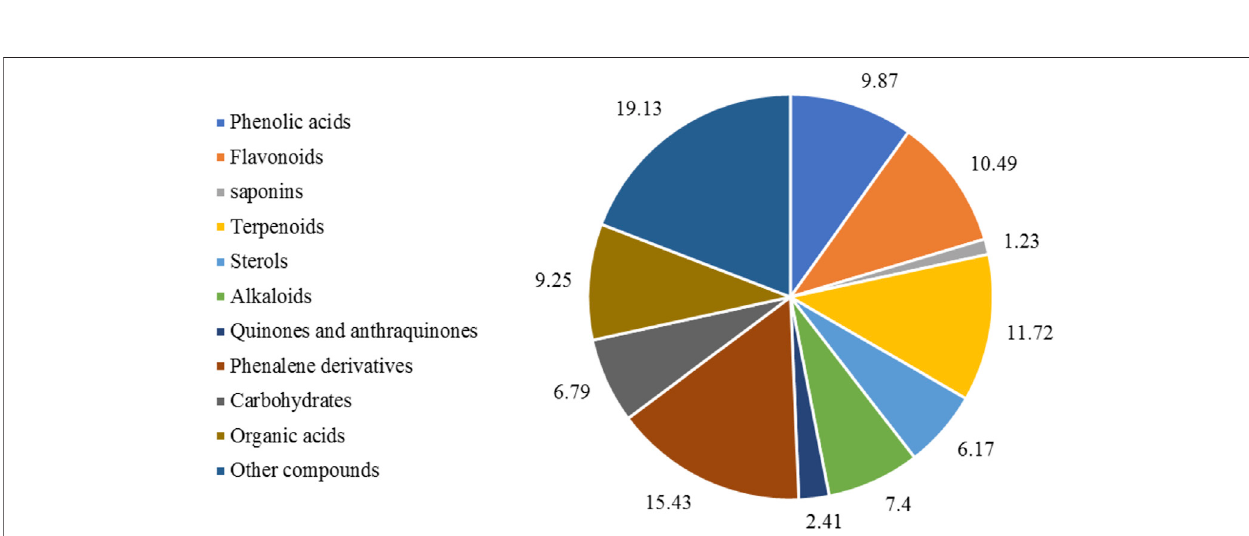
FIGURE3| Majorclassesandsubclassesofcompoundsisolatedfrom E.crassipes basedonthetotalnumberofphytochemicals.ThekeywordsusedontheWeb of Science were “ E . crassipes , ” OR “ water hyacinth ” “ phytocompounds, ” “ secondary metabolites, ” “ phenolic, ” “ fl avonoids, ” “ saponins, ” “ sterols, ” “ terpenoids, ” “ carbohydrates, ” “ quinones, ” “ tannins, ” “ organic acids, ” and “ other compounds. ”